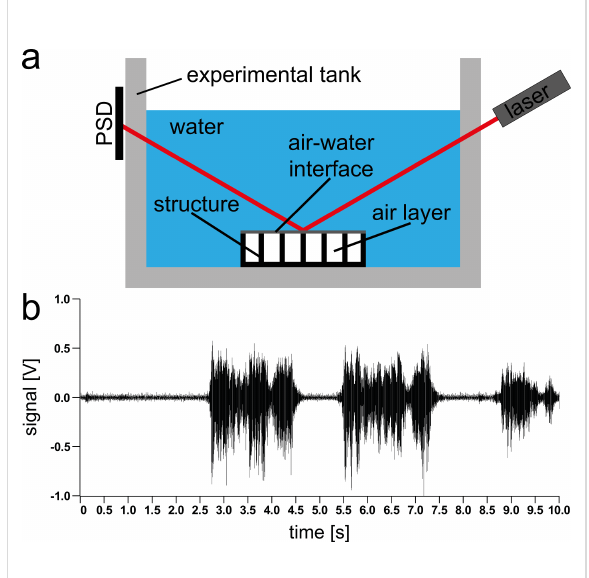
Figure 8: a) Setup used for the proof of concept for the biomimetic Notonecta sensor inspired by the backswimmer hemelytra surface. An air-retaining surface was placed at the bottom of a water-filled aquarium. A laser beam hit the air–water interface at an angle of about 30°. The reflected beam was detected by a photosensitive diode (PSD) placed at the opposite side of the aquarium. A temporary displace- ment of the air–water interface due to pressure changes led to beam deflection, thus the diode signal could be used to detect vibrations at the interface. b) Diode signal recorded in the experiment described in (a). The graph shows the output voltage of the diode which